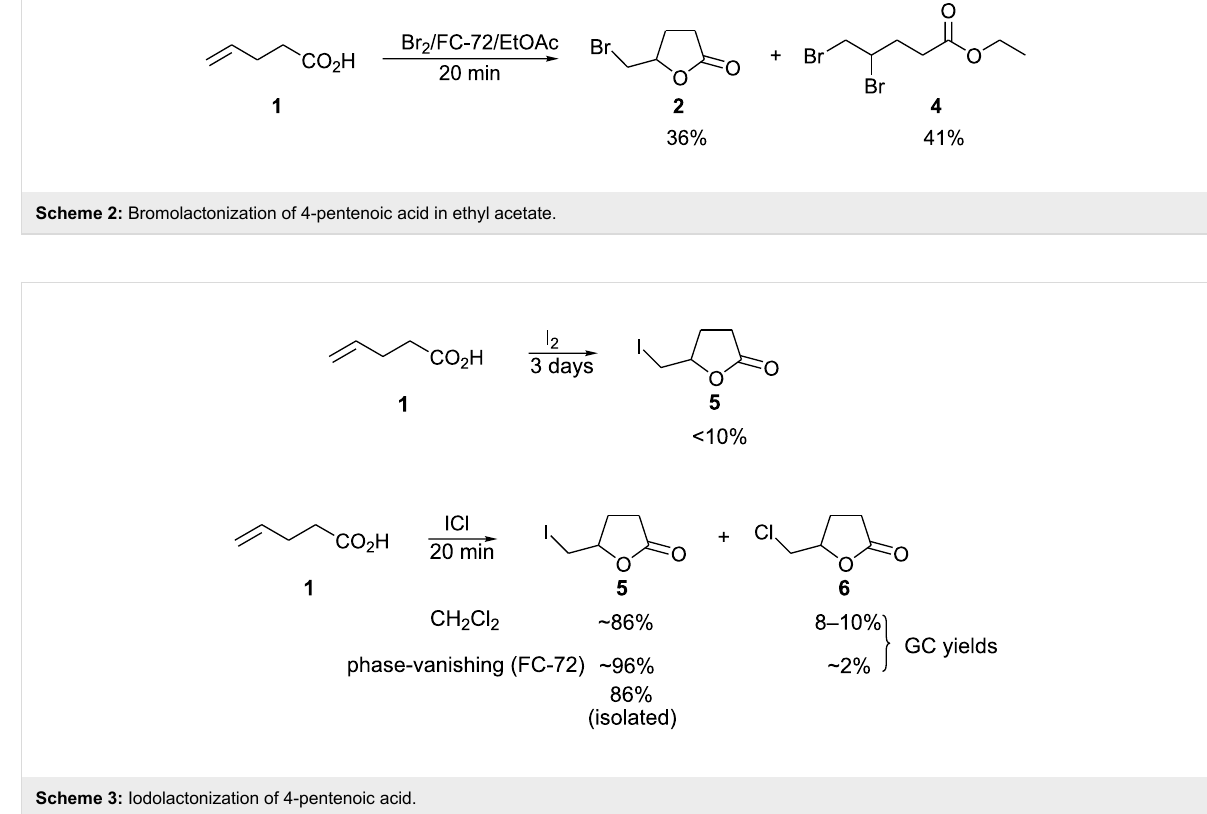
Scheme 3: Iodolactonization of 4-pentenoic